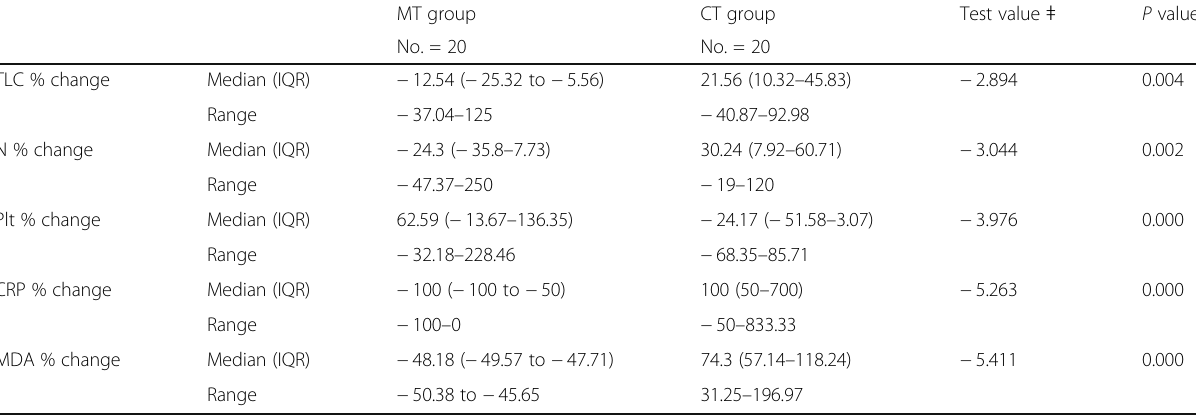
Table 1 Comparison of the percentage of change of different laboratory parameters between MT and CT groups MT group CT